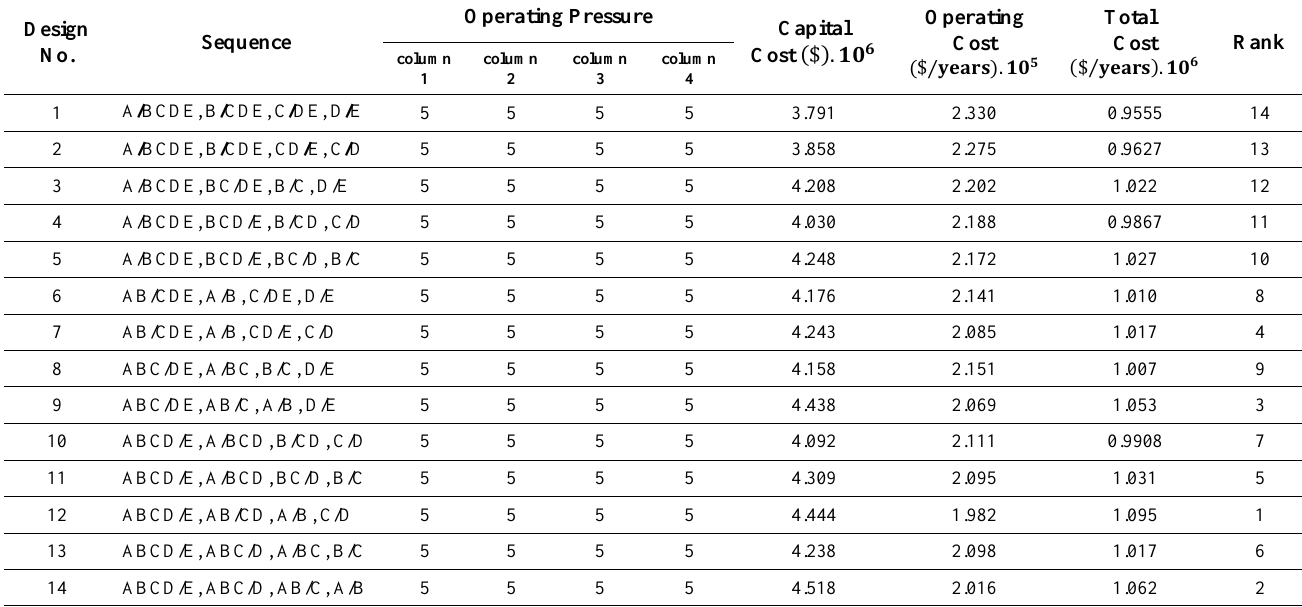
Table 10. Retrofitting all of the feasible column sequences considering fixed target trays and have been ranked based on Total Annual Cost (TAC) as an object function.